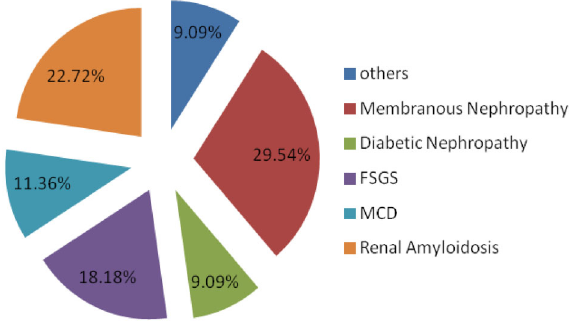
Figure 1. Distribution of the main histological diagnoses from renal biopsies in patients over 65 years of age with nephrotic syndrome. FSGS: focal segmental glomerulosclerosis; MCD: minimal change